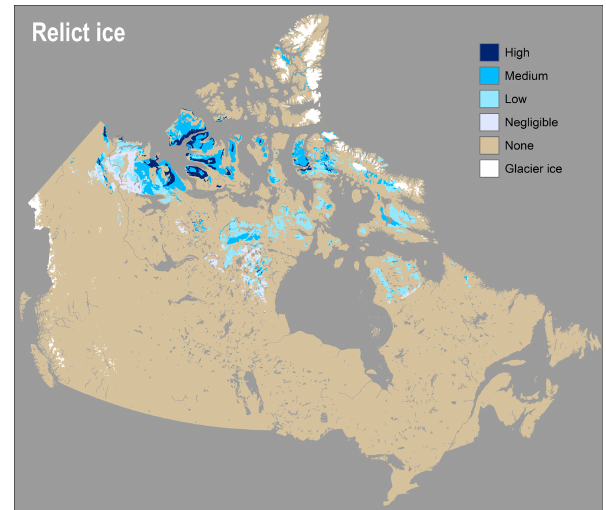
Figure 2. Modelled relict ice